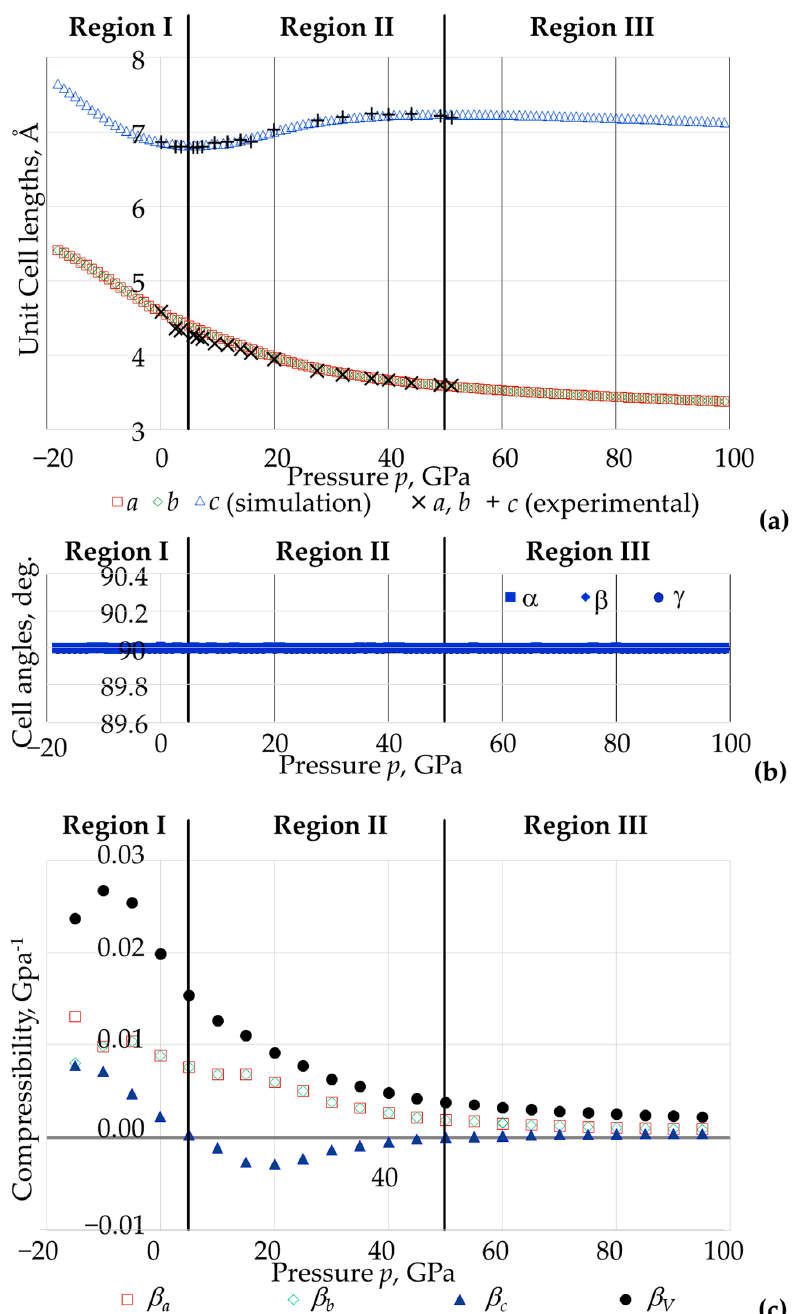
Figure 6. ( a ) The lattice constants a , b , c as simulated compared with the experimental data (shown as black crosses) as obtained by Haines et al. [3]. Note the excellent agreement between the simulated data and the available experimental data. ( b ) A confirmation that the lattice cell angles remain 90 ° throughout the entire pressure range considered means that lattice vectors a , b and c remain aligned with the x , y and z directions respectively. ( c ) The linear and volume compressibility values as computed from the simulated data. Note that Region II corresponds to NLC in the c direction. A visual comparison of these systems indicates that an increase in pressure results in very prominent shrinkage in the a and b unit cell dimensions together with a visible re-orientation of the tetrahedra, where each tetrahedron rotates about an axis which is parallel to the [001] direction and corresponds to the aforementioned perpendicular